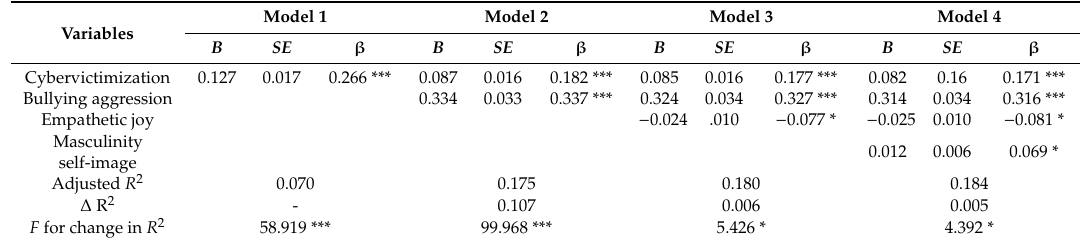
Table 5. Predictor variables of cyberaggression for